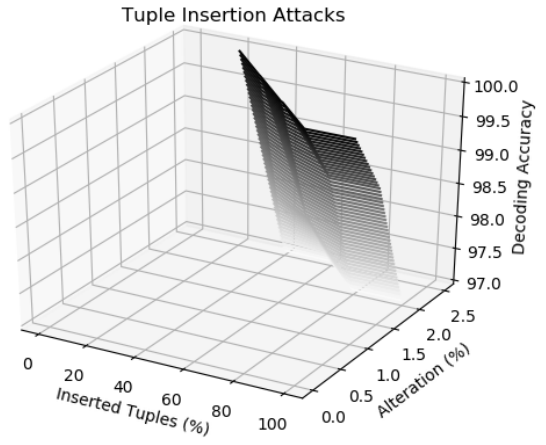
Figure 5. Robustness against tuple insertion